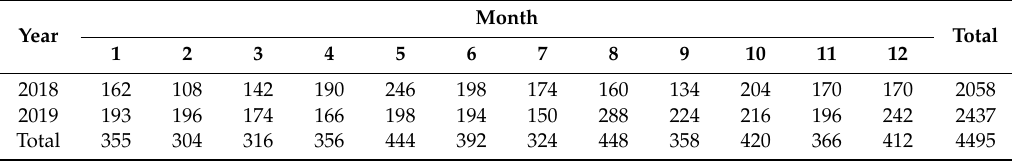
Table 1. Historical sale data of Piston rings added up to 24 months